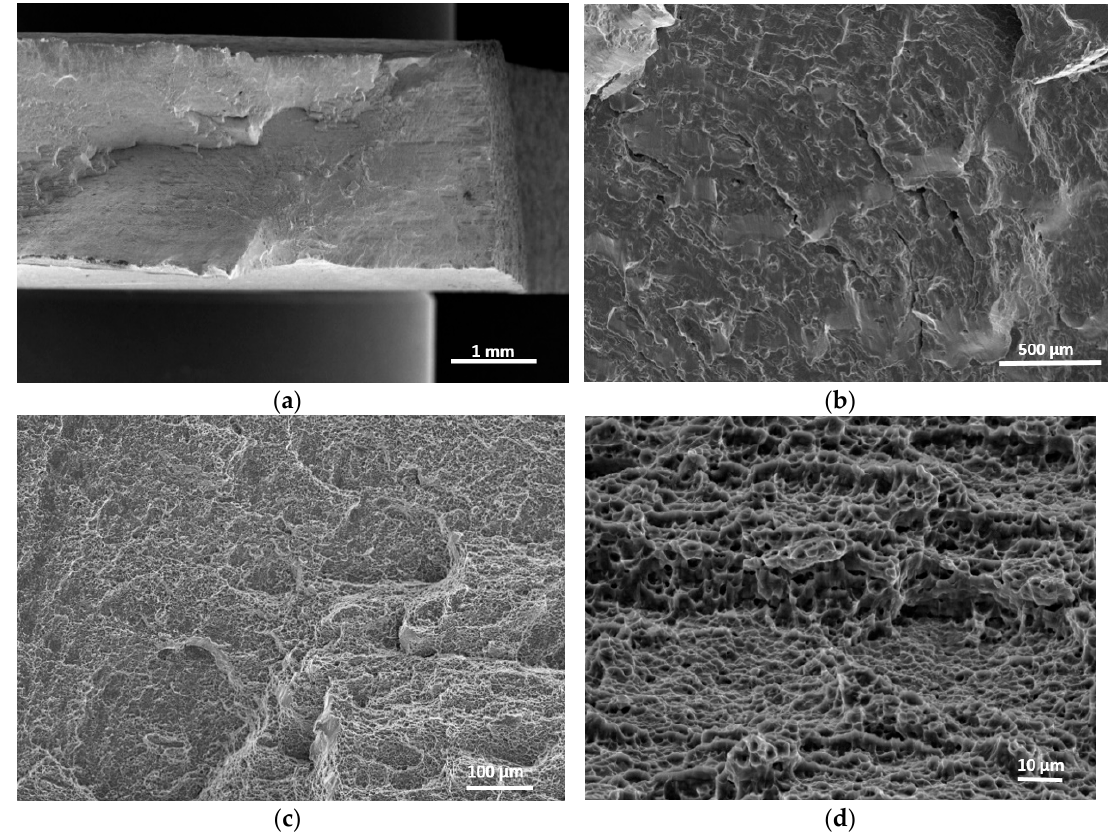
Figure 5. Fracture surface of the specimen from the VT23 alloy under static stretching (curve 19 in Figure 3) obtained at macro ‐ ( a , b ) and micro ‐ ( c , d ) levels.